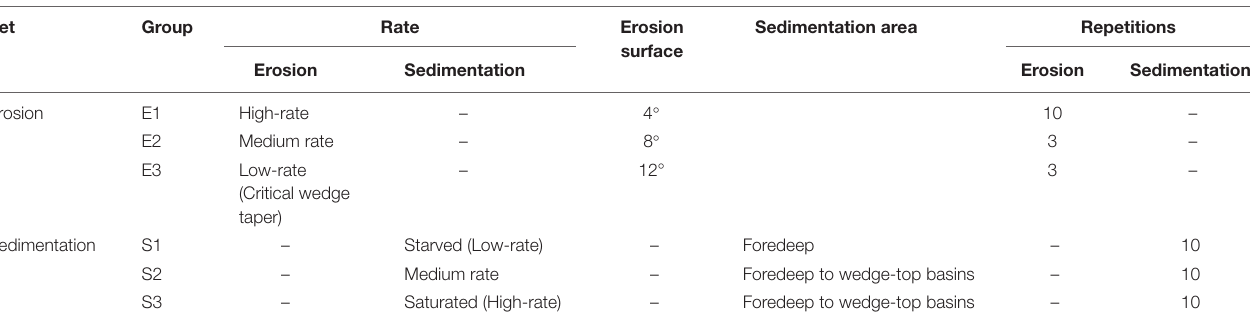
FIGURE 1 | (A) Diagram of the experimental apparatus. (B) Interpreted fold-thrust wedge showing the parameters measured in the experiment. Note that the distance between frontal thrust and backstop is about 7.5 mm shorter than the original definition of wedge length (Dahlen et al., 1984; Dahlen, 1990). (C) Erosion models with constant erosion slope angles to represent different rates of erosion. (D) Sedimentation models with constant deposited slope angle with different area to represent different rates of sedimentation. TABLE 1 | Summary of experimental